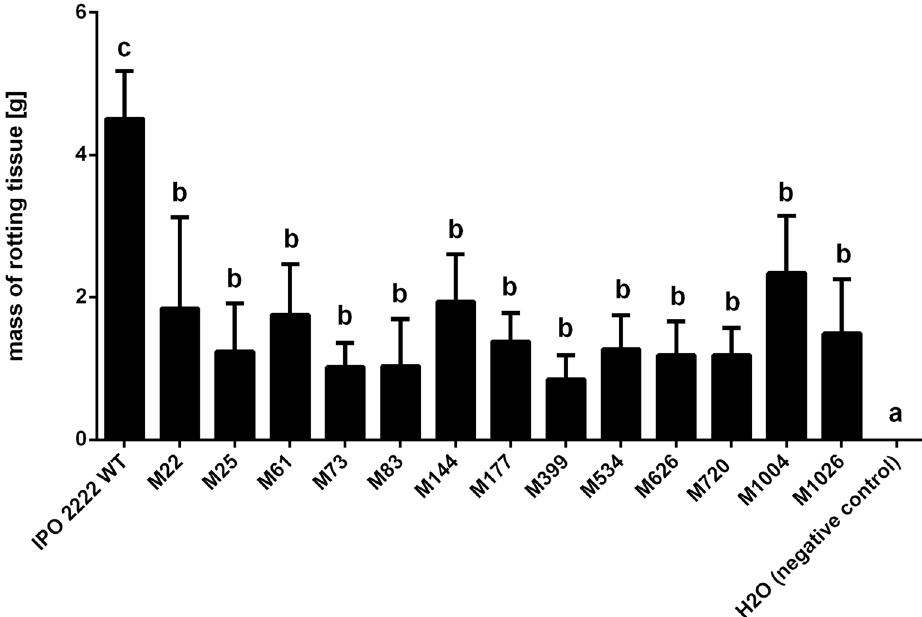
Figure 9. Maceration of potato tuber tissue by D. solani WT and phage-resistant mutants. Five individual potato tubers were inoculated with a given phage-resistant bacterial mutant using a whole tuber injection method (stab inoculation) 103,106 . Bacterial strains were grown in TSB (WT strain), or TSB supplemented with 50 µg mL -1 of neomycin (Tn5 mutants) for 24 h at 28 °C. After incubation, bacterial cultures were separately collected, washed two times with 1/4 Ringer’s buffer and resuspended in the initial volume of Ringer’s buffer. Optical density (OD600 = 0.1) was used to normalize the number of bacterial cells in all treatments (ca. 10 8 CFU mL -1 ). Surface-sterilized potato tubers were stab-inoculated with sterile yellow pipette tip filled with 50 µl of bacterial suspension (treatments) or sterile Ringer’s buffer (negative control). IPO 2222 WT was used as a positive control. Results were considered to be significant at p = 0.05 and pair-wise differences were obtained using the t-test. Error bars represent standard deviation